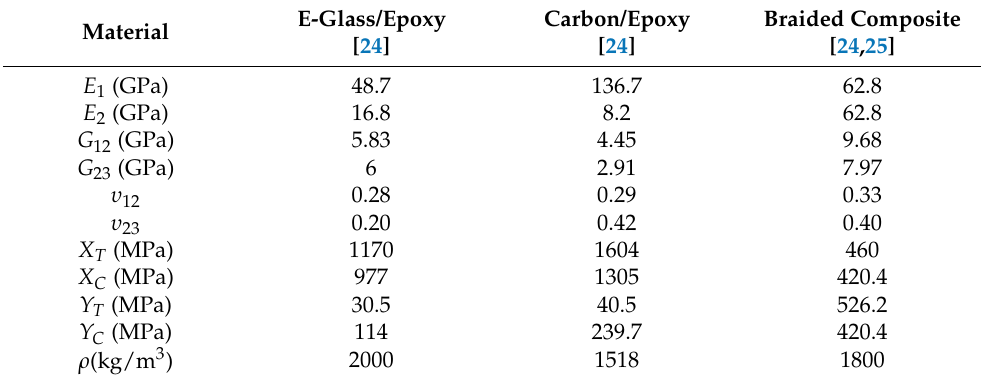
Table 2. Material properties of wind turbine blade.